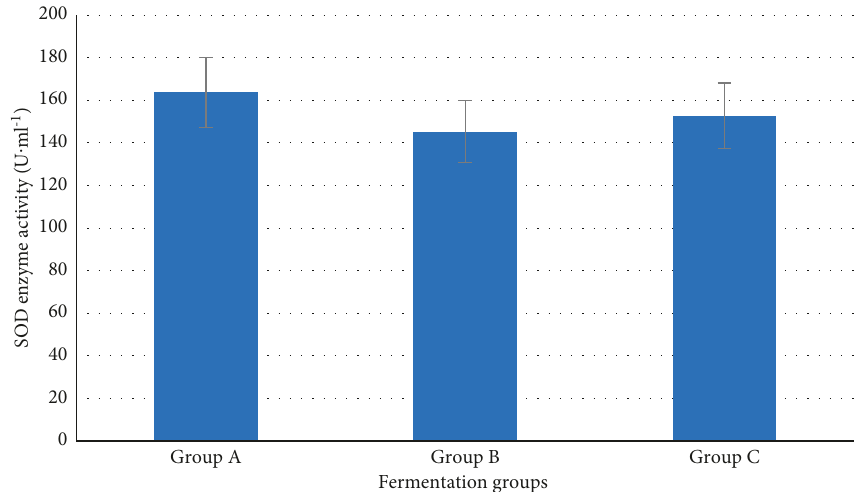
Figure 3: SOD enzyme activity values under mixed strain fermentation conditions ( P